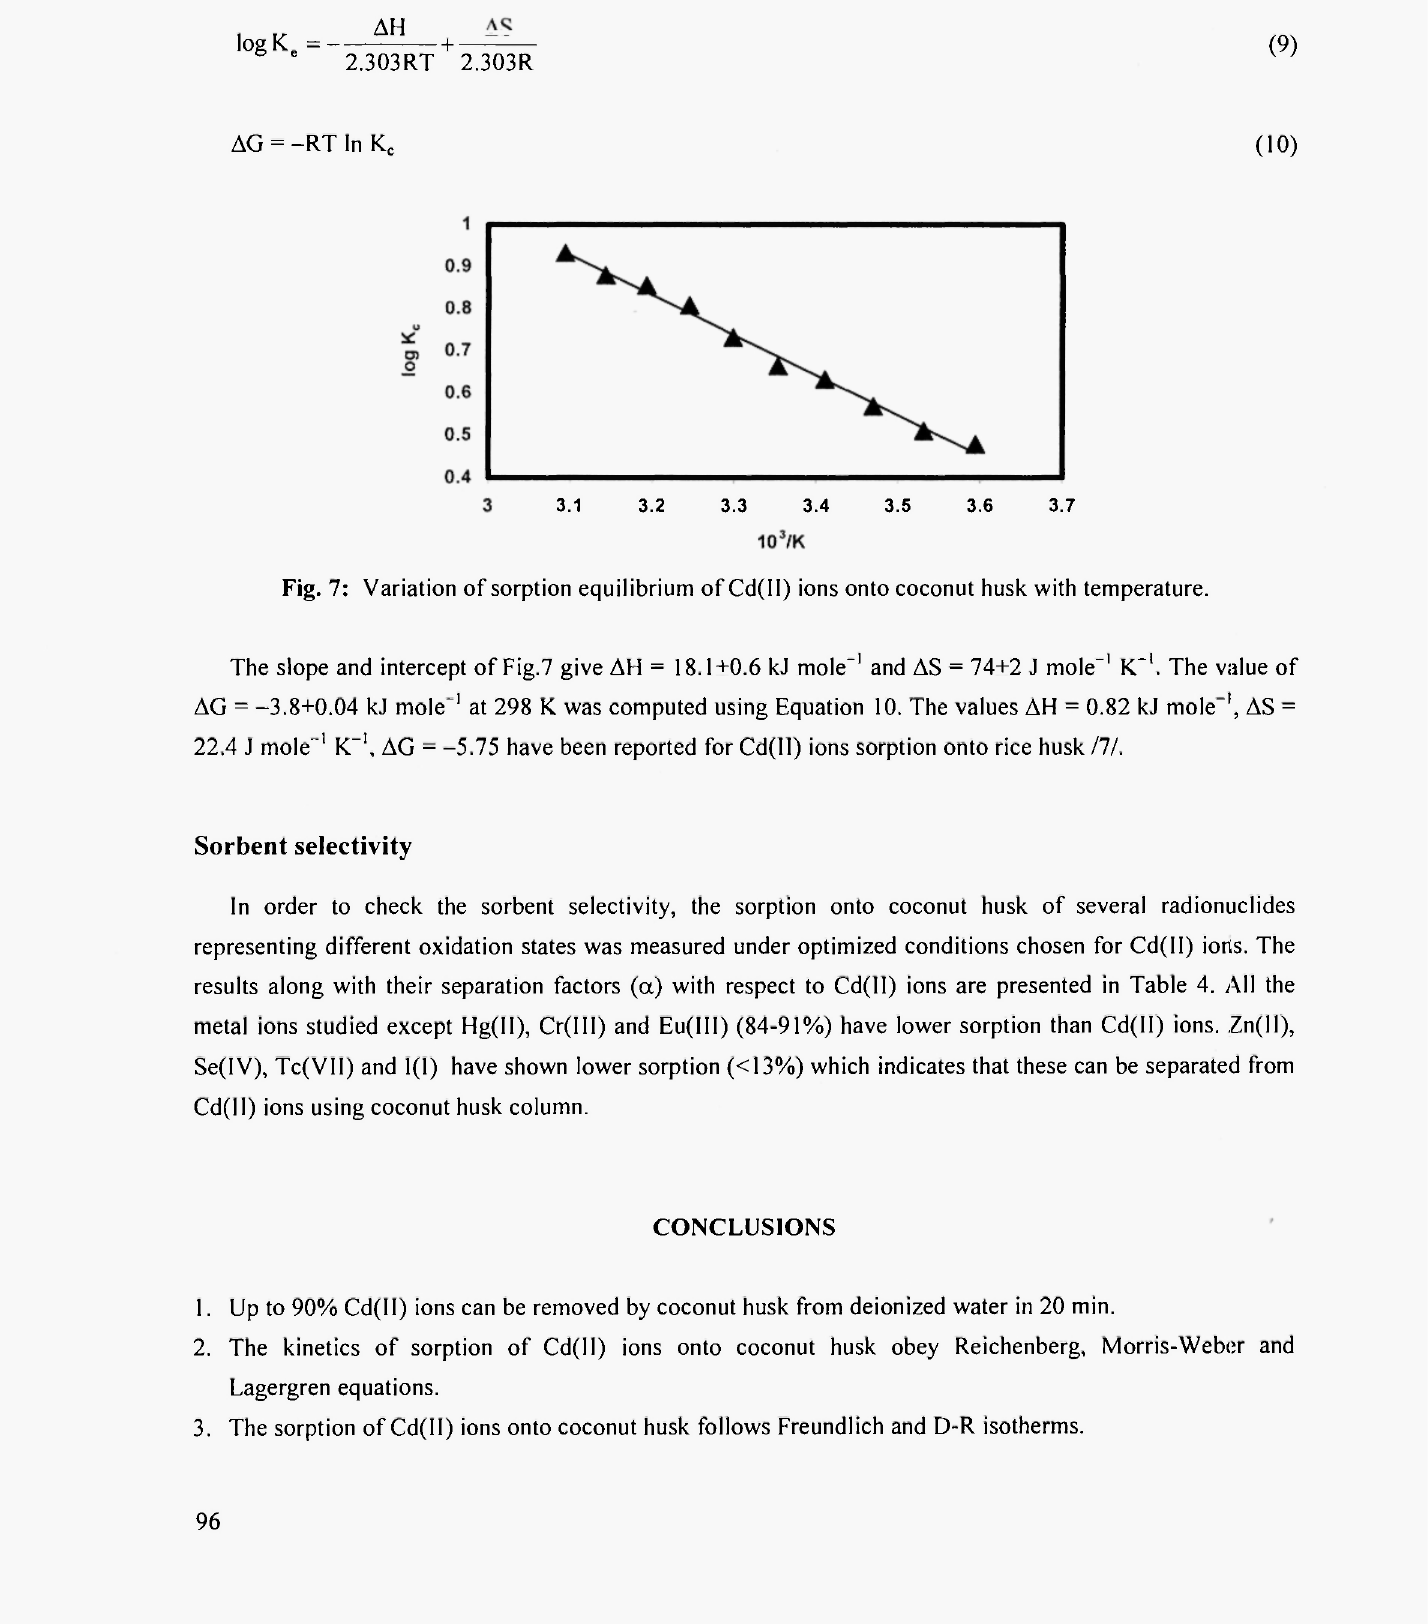
Fig. 7: Variation of sorption equilibrium of Cd(II) ions onto coconut husk with temperature.